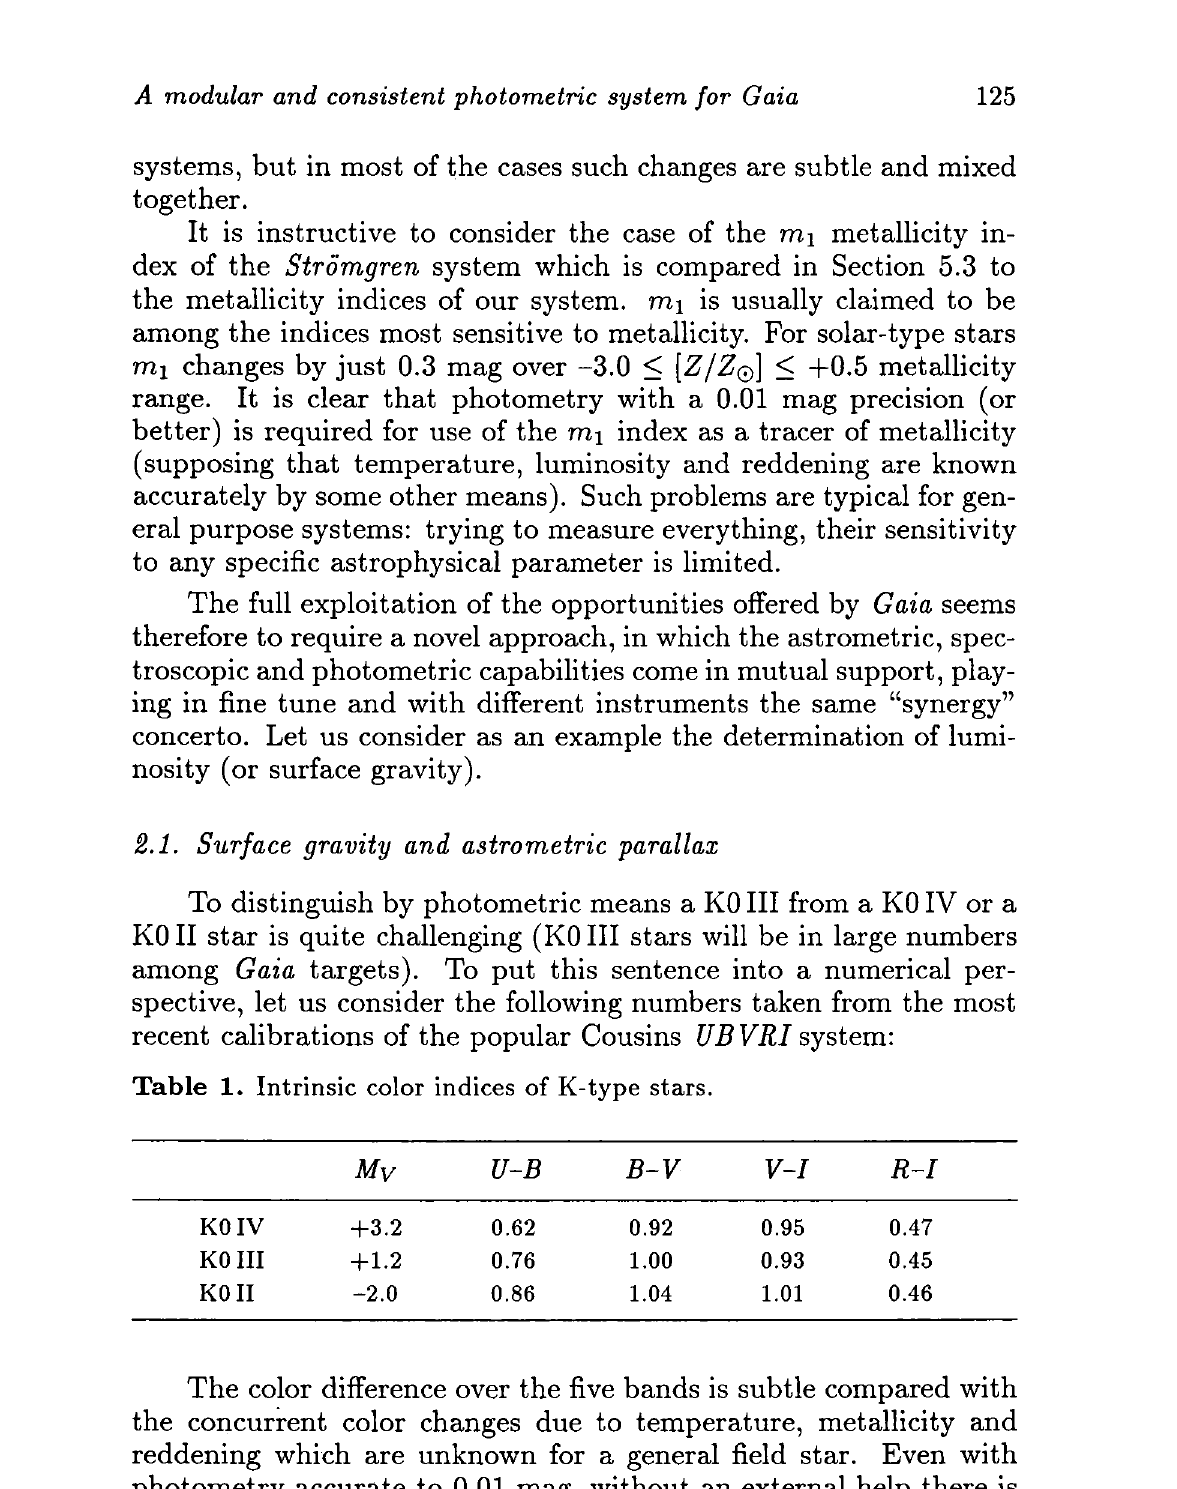
Table 1. Intrinsic color indices of K-type stars.